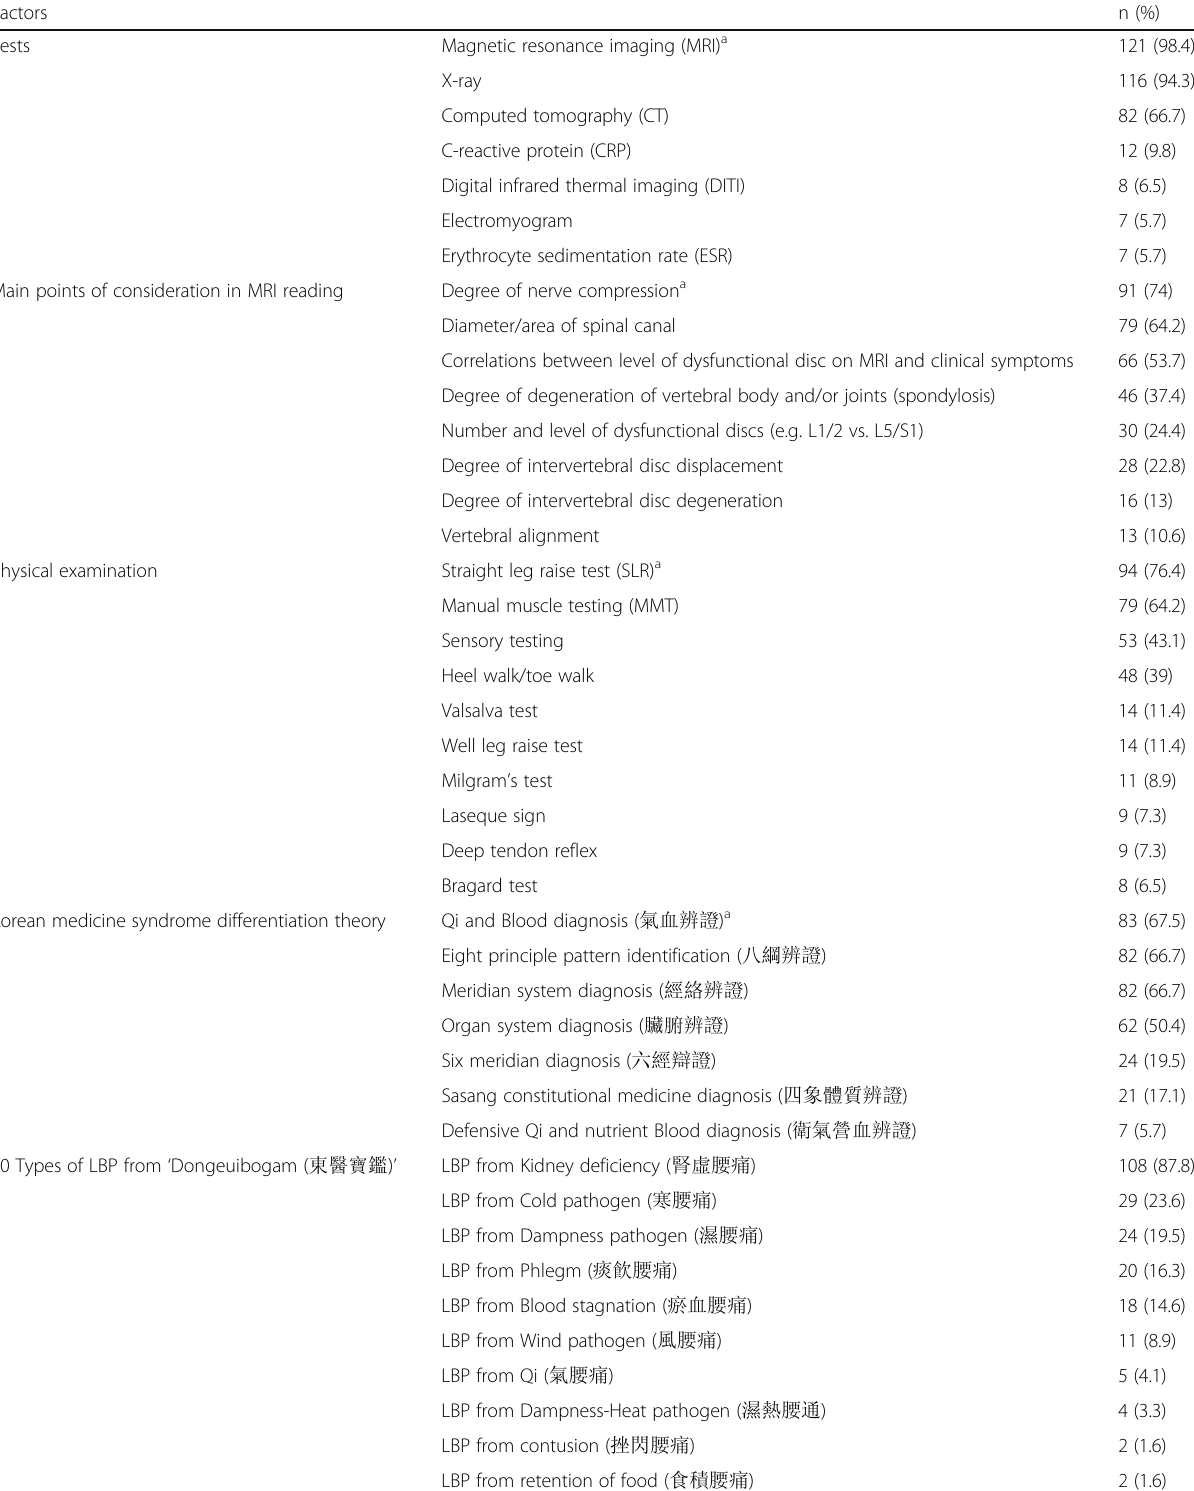
Table 4 Diagnostic tools used for LSS and Korean medicine syndrome differentiation